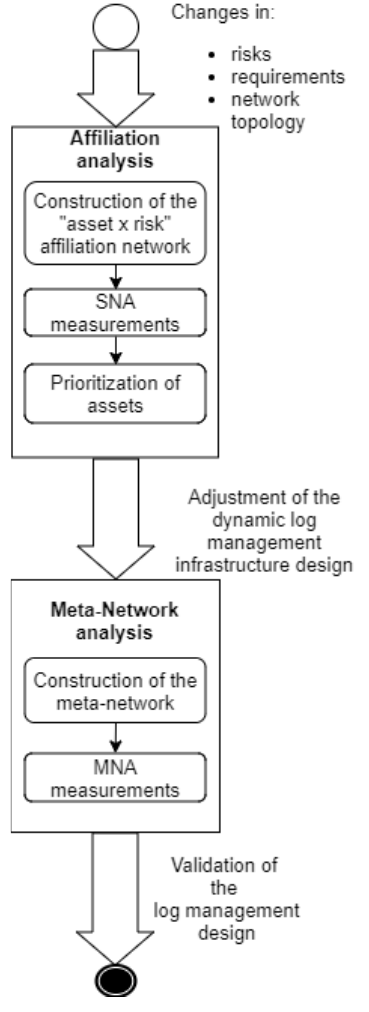
Figure 1. Overview of the proposed